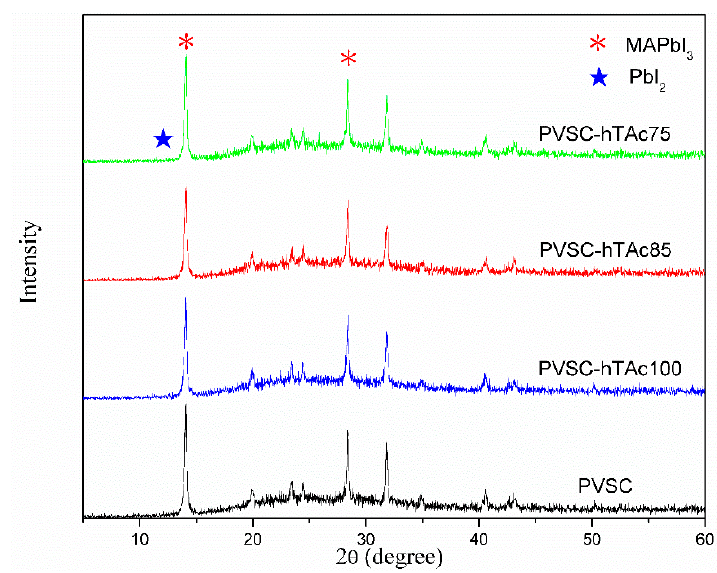
Figure 3. XRD patterns of MAPbI 3 layer incorporated with various h-TAc contents.